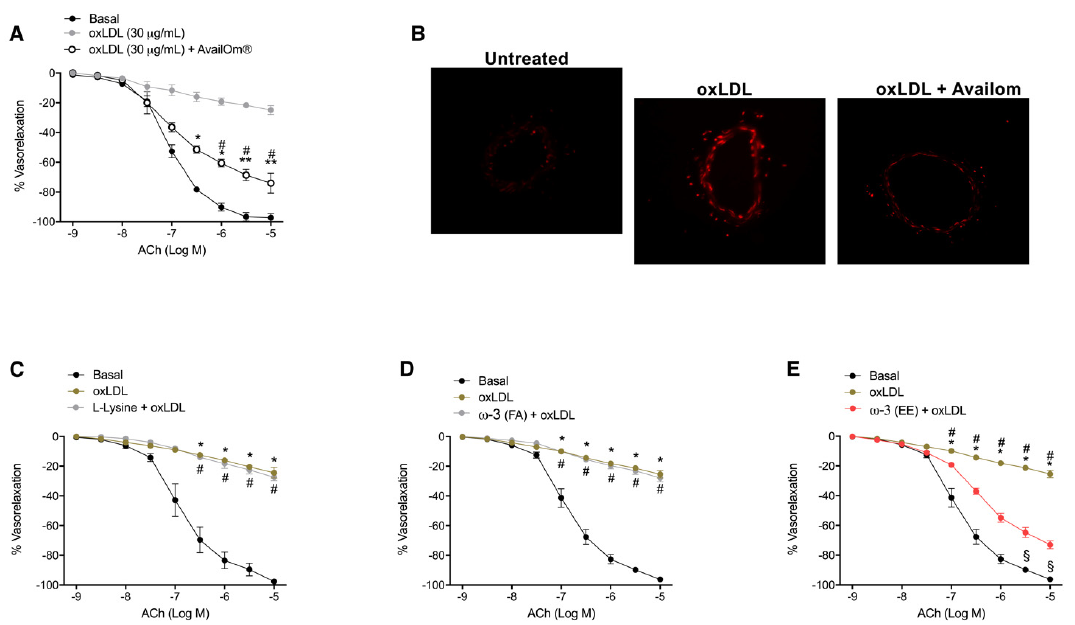
Figure 2. Vasculoprotective effect of ω -3 Ethyl Ester against oxLDL-induced oxidative stress and endothelial dysfunction. ( A ) Vascular reactivity studies of phenylephrine-precontracted mice mesenteric arteries exposed to increasing doses of ACh (10 − 9 to M 10 − 5 M) after exposure to oxLDL for 30 min and to 1 h to AvailOm ® (100 µ g/mL). ( B ) Representative high-power micrographs of mice mesenteric arteries cryosections loaded with dihydroethidium probe at the concentration of 5 µ M. Vessels were pre-treated with a single compound (100 µ g/mL) for 1 h and then stimulated with oxLDL for 30 min before the acquisition. ( C – E ) Vascular response of phenylephrine-precontracted mice mesenteric arteries to increasing doses of ACh (10 − 9 to M 10 − 5 M) after exposure to oxLDL for 30 min and to